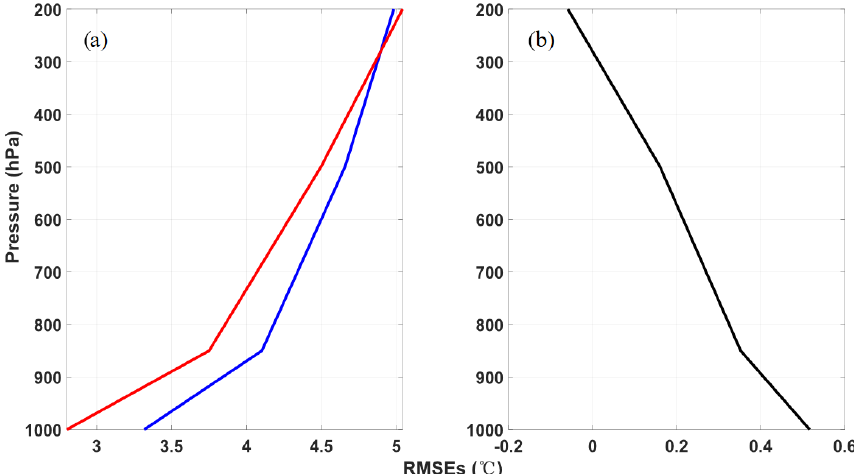
Figure 7. The (a) variations of RMSE of air temperature with air pressure between the WRF-SOM and WRF-ROMS against the CFSv2 reanalysis averaged in the 34d of total 142 forecast cases from 19 July to 31 December 2020, and the (b) variation of the difference of RMSEs in two models with the air pressure.